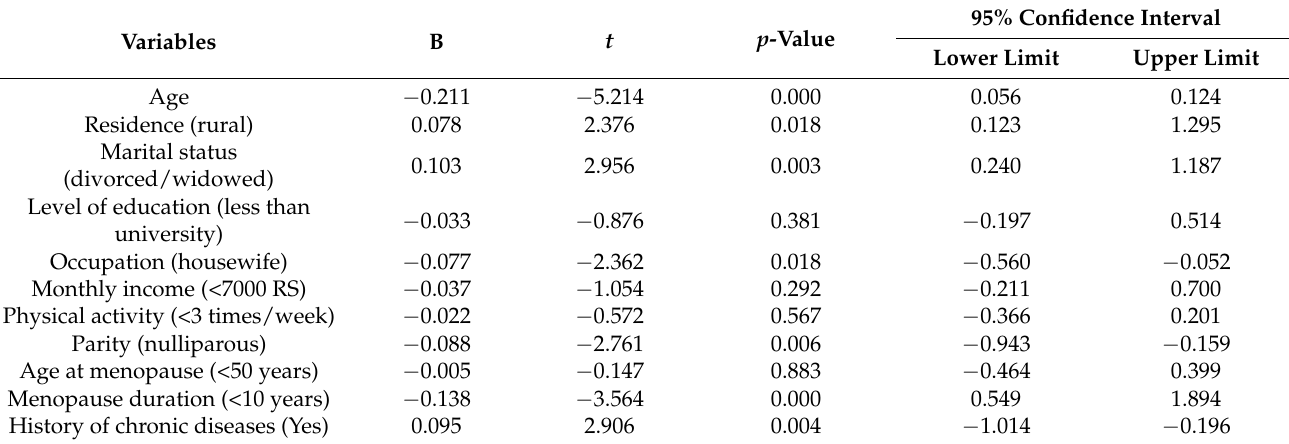
Table 5. Linear regression model showing the predictors of the psychological domain in MRS score among Saudi women attending different primary health centers.